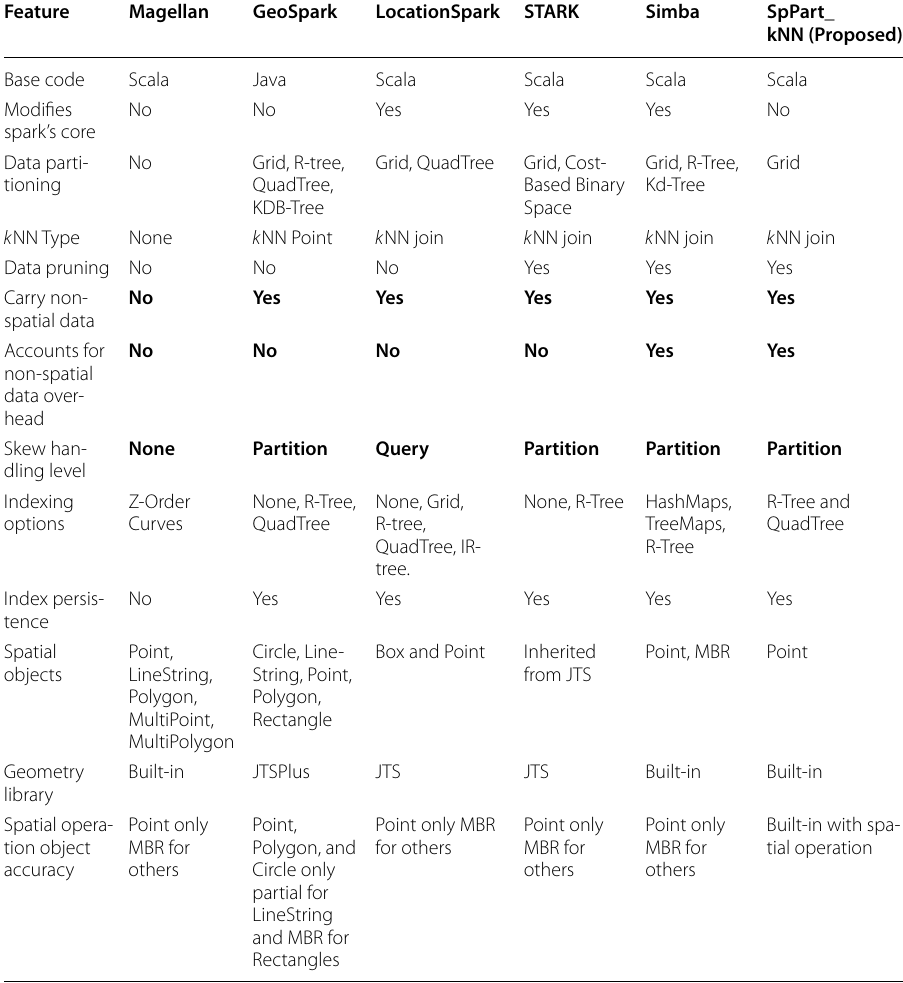
Table 1 Feature comparison of Spark-based k NN spatial extensions Feature Magellan GeoSpark LocationSpark STARK Simba SpPart_